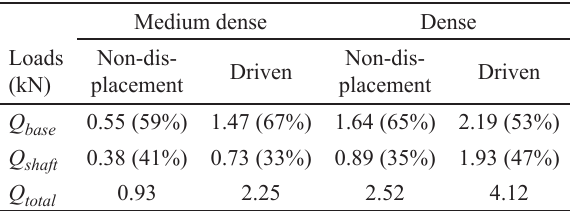
Table 4. Ultimate, shaft, and base loads for single model piles in sand Medium dense Dense